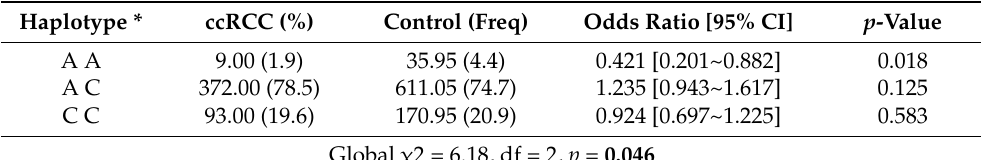
Table 3. Haplotype distribution of TIM-3 SNPs between ccRCC patients and controls. Haplotype *